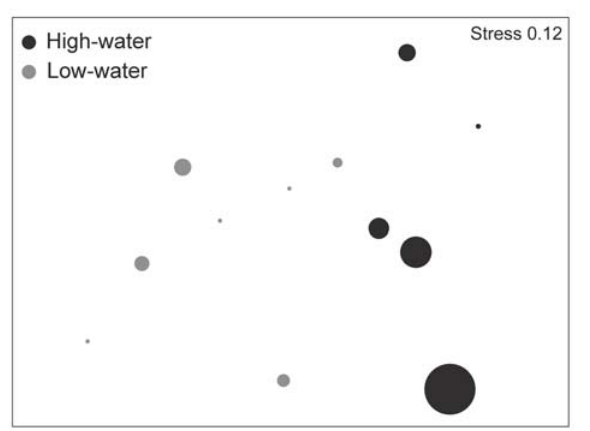
Fig. 4. Multidimensional scaling plot of Hypostomus hermani abundance in the riffle reach showing its predominance (shown by circle size) during the high-waters. Each symbol represents a month.